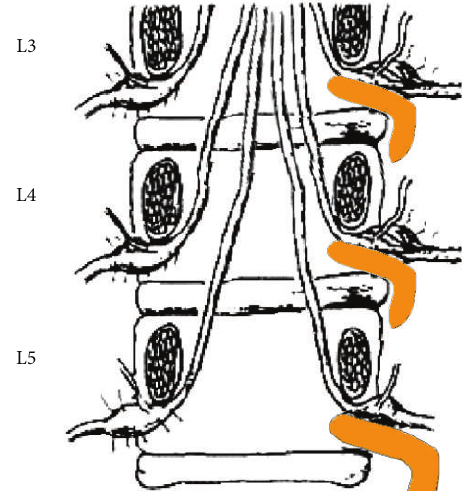
Figure 1: Schematic diagram of the compression of the DRG in the mCCD